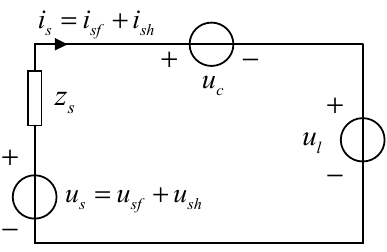
Figure 2. SAPF single-phase equivalent circuit diagram.